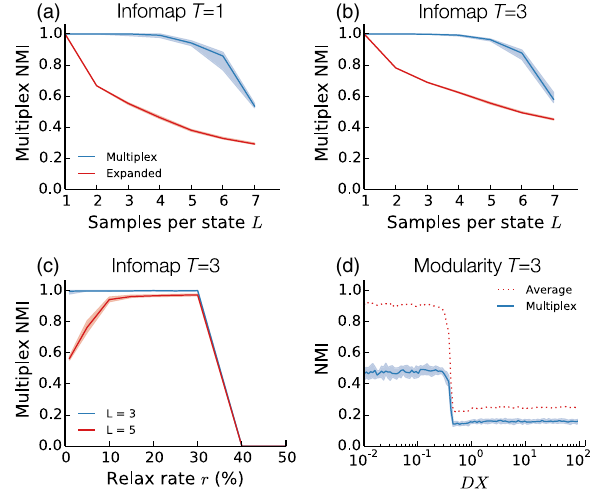
FIG. 3. Performance test on multilayer benchmark networks. (a,b) Performance of multiplex Infomap (Multiplex) compared with Infomap applied to the expanded network with state nodes interpreted as physical nodes (Expanded) and to each network layer separately (Single) as a function of number of network layers for 1 and 3 mode networks, respectively. We used relax rate r ¼ 0 . 15 and quantified the performance by the NMI between the planted and obtained partitions of state nodes. (c) Performance of multiplex Infomap as a function of the relax rate r . (d) Perfor- mance of generalized modularity optimization for T ¼ L ¼ 3 as a function of the interlayer coupling DX , measured both as the NMI of state nodes (Multiplex) and averaged across network layers (Average).